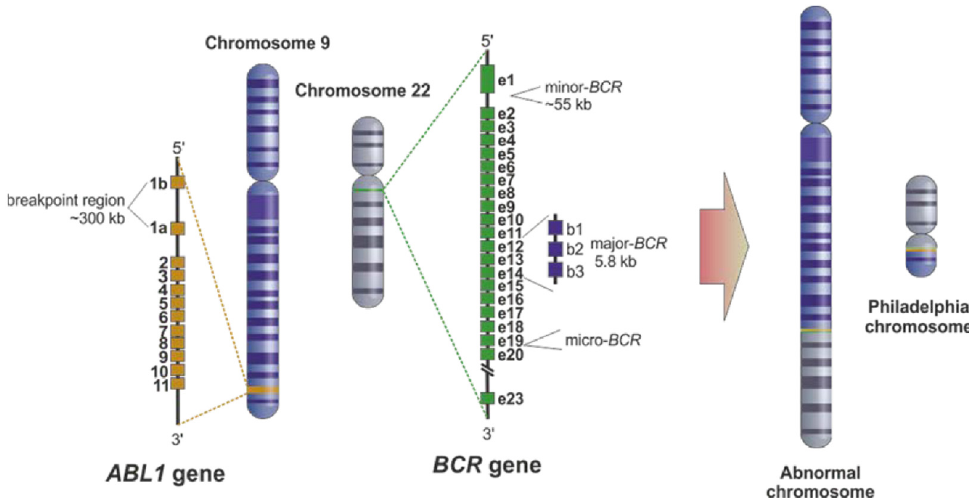
Figure 1. The origin of the Philadelphia chromosome. The Philadelphia chromosome results from the translocation between the Abelson murine leukemia ( ABL1 ) gene on chromosome 9 with the breakpoint cluster region ( BCR ) gene on chromosome 22. Three break point regions might be involved in this translocation: (i) intron 13 or 14 of BCR , named major breakpoint (M- BCR ), (ii) intron 1 of BCR , named minor breakpoint (m- BCR ), and (iii) exon 19 of BCR , named µ breakpoint ( µ - BCR ). Concerning ABL1 , the breakpoint usually involves the region between exons 1b and 2.